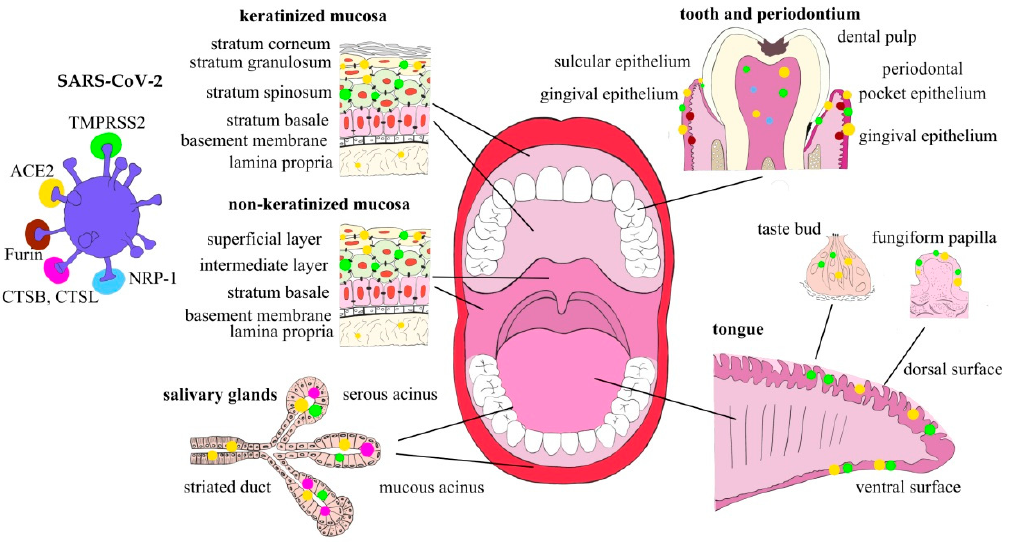
Figure 1. Expression of SARS-CoV-2 entry and transmission factors in the oral cavity